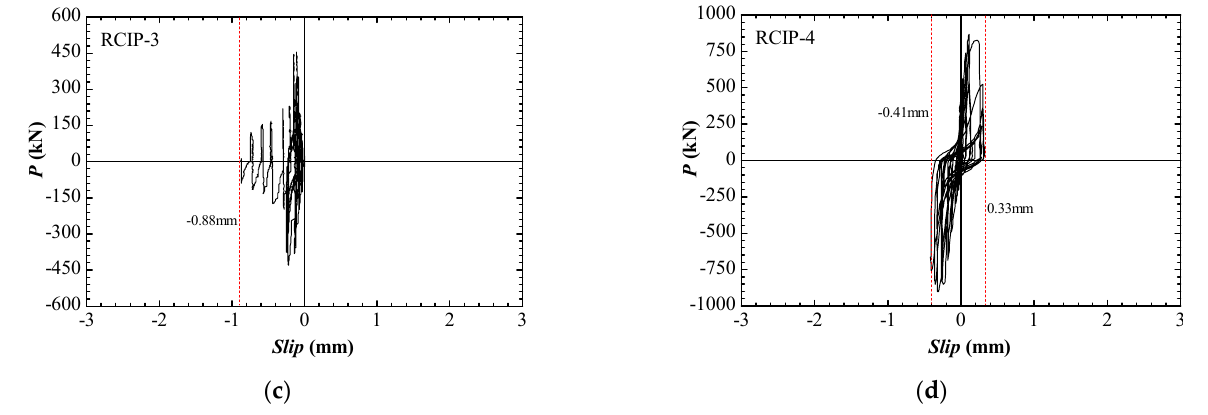
Figure 19. Curves for lateral load versus top interface slip: ( a ) RCIP-1; ( b ) RCIP-2; ( c ) RCIP-3; ( d ) RCIP-4.